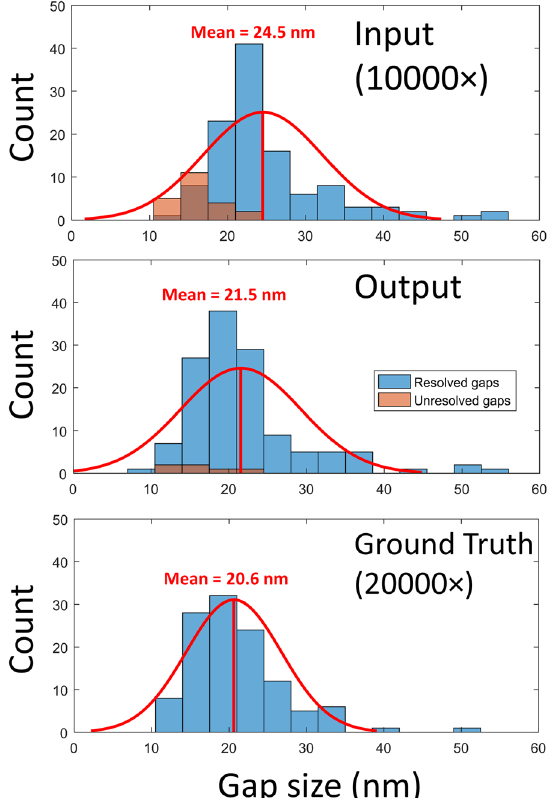
Figure 3. Histograms of the gap sizes inferred from the network input and the output images compared to the ground truth image. Total count changes among the histograms due to some of the gaps only being visible in specific images. In the input SEM images, 13.9% of the gaps were not detectible; the percentage of undetected gaps dropped to 3.7% for the output images. A Gaussian distribution, fitted to the gap histograms, with the corresponding mean gap size is also shown for each plot. The number of unresolved gaps in both the input and output images is also shown using a different color; unresolved gaps were not used for mean gap estimation. Pixel size per image is 7.1 nm; the input image is upsampled by a factor of 2.